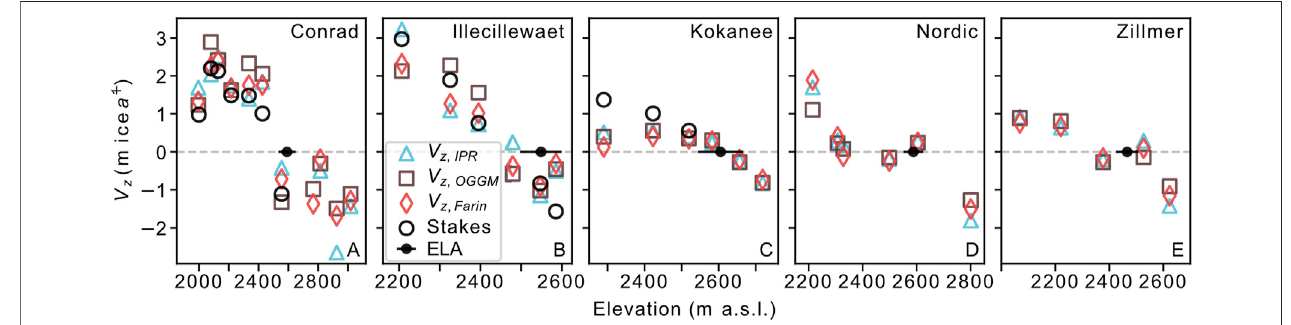
FIGURE 7 | Vertical ice velocity from model estimates using the three ice thickness sources (IPR, OGGM, FAR19) and ablation stakes observations ( Eq. 5 ), here averaged over the fl ux bins. The ELA is taken as the average ELA (de fi ned here as the mean TSL elevation from satellite imagery at the end of the ablation season) from 2013 to 2018 ± 1 σ .